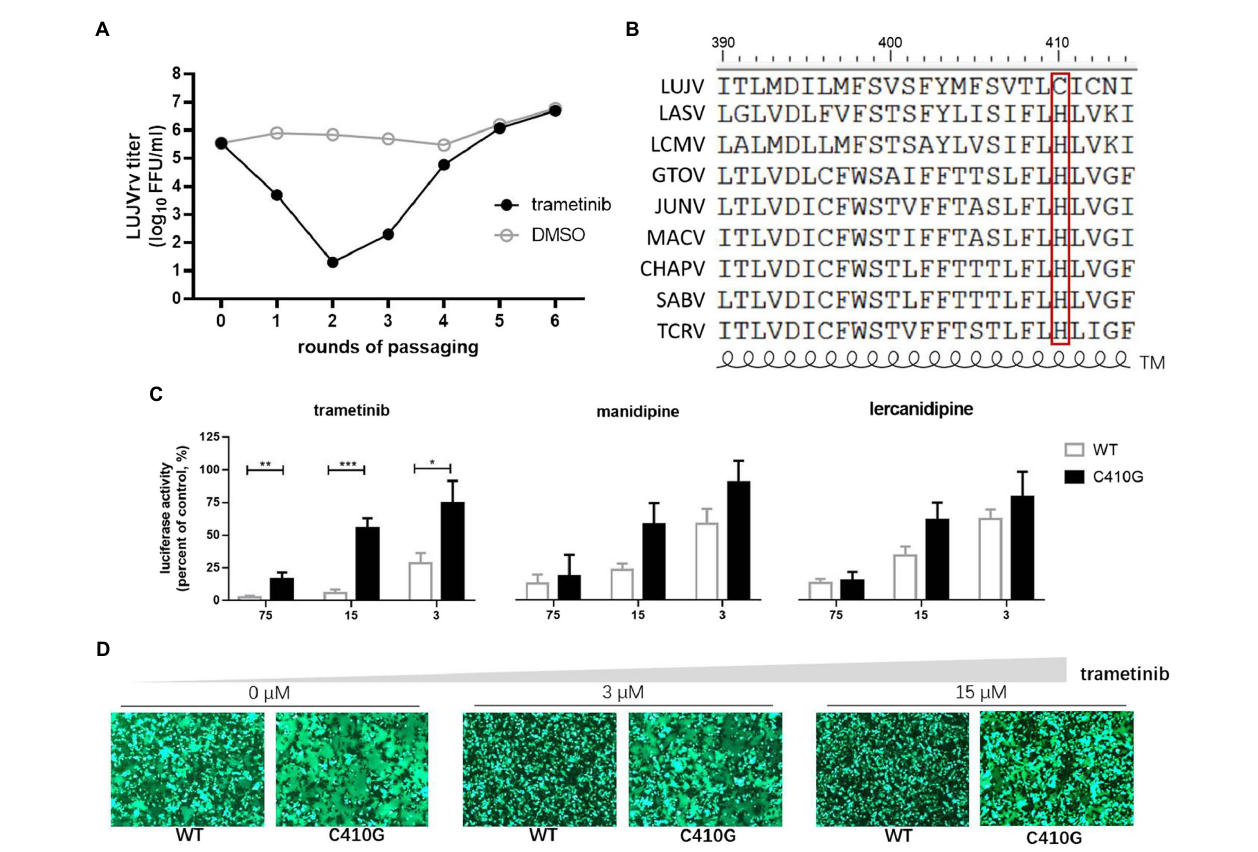
FIGURE 3 | Selection of trametinib-resistant LUJVrv. (A) The adaptive mutant virus was selected by serially passaging LUJVrv in the presence of 10 μ M trametinib. In a parallel experiment, LUJVrv passaging in vehicle served as a control. After six rounds of passaging, no further improvement in resistance was detected, and the selection was terminated. (B) Amino acid sequence alignment of the mammarenavirus transmembrane (TM). (C) Resistant activities to trametinib of the wild type (WT) and C410G LUJVpv. Vero cells were treated with compounds at the indicated concentrations; 1 h later, WT or C410G LUJVpv (MOI, 0.1) was added to the culture for 1 h. The infected cells were lysed 23 h later, and the luciferase activities were measured. Data are presented as means ± SD, from 2 or 3 independent experiments (*** p < 0.001; ** p < 0.01; and * p < 0.05). (D) C410G conferred resistance to the inhibition of trametinib against LUJV GPC-mediated membrane fusion. Images are representative fields from three independent